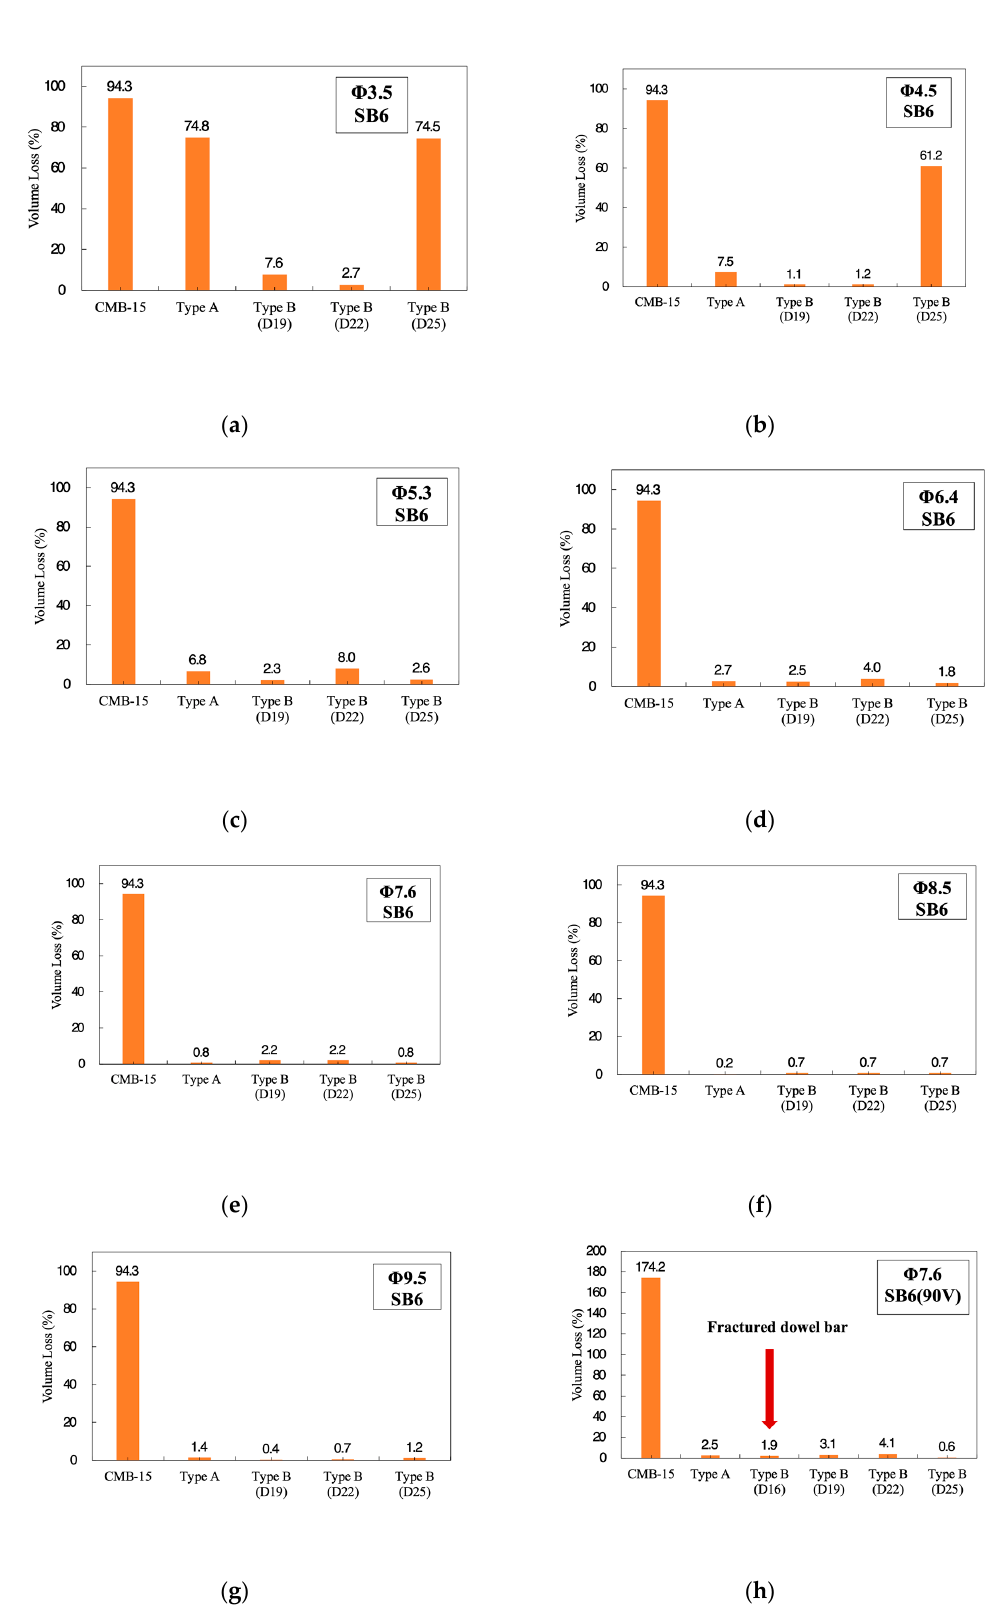
Figure 5. Obtained volume loss depending on the size of wire-mesh under SB6 impact severity. ( a ) Wire size—ø3.5; ( b ) Wire size—ø4.5; ( c ) Wire size—ø5.3 (SB6); ( d ) Wire size—ø6.4 (SB6); ( e ) Wire size—ø7.6 (SB6); ( f ) Wire size—ø8.5 (SB6); ( g ) Wire size—ø9.5 (SB6); ( h ) Wire size—ø7.6 (SB6(90V)).